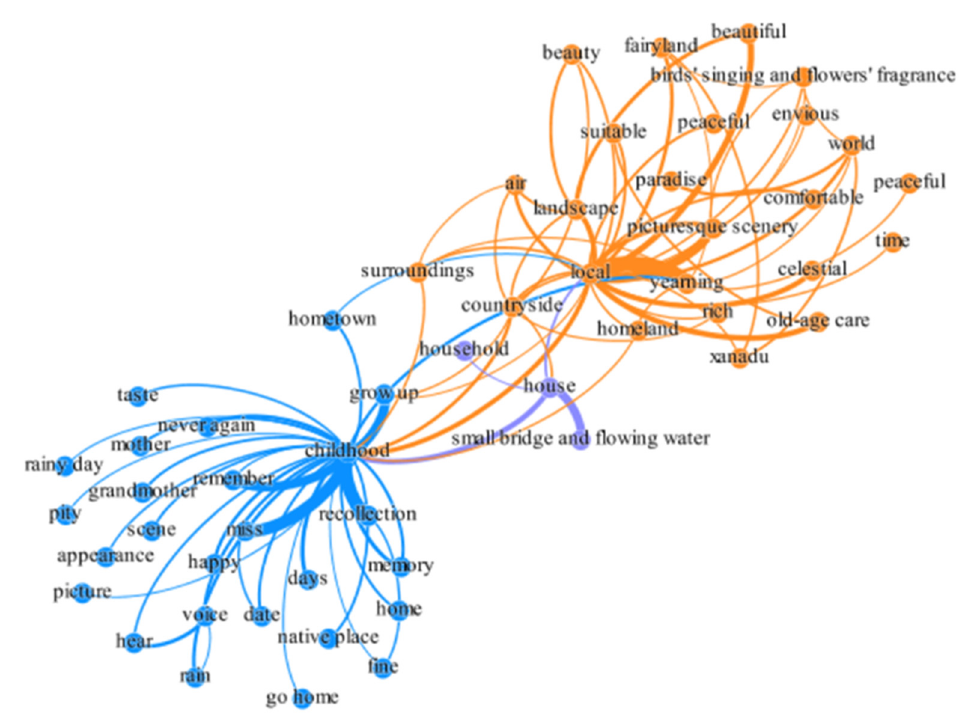
Figure 3. Semantic network analysis results of the rural landscape review.